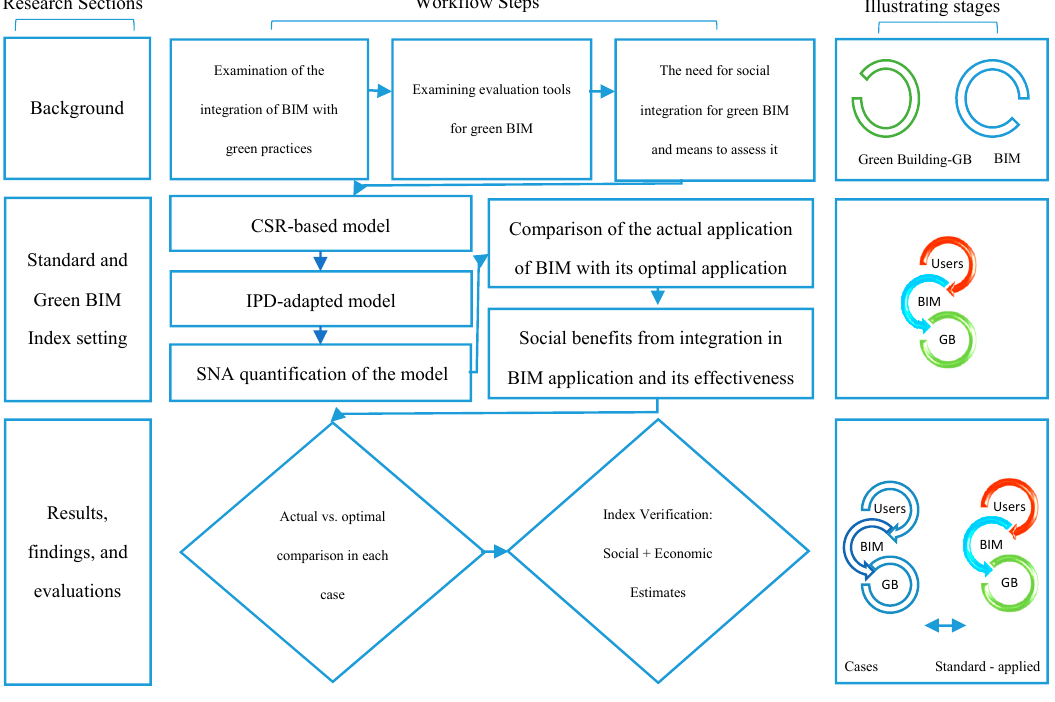
Figure 2. Outline of the research workflow.